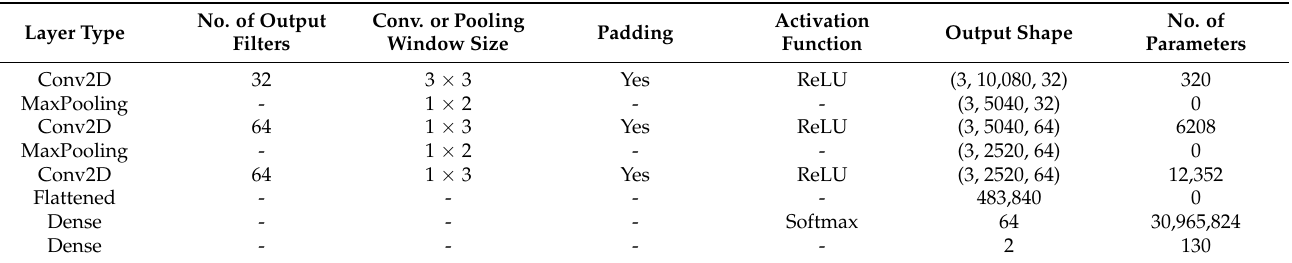
Table 2. Proposed convolutional neural network configuration for week-long three-component geo- magnetic field recordings with a sampling rate of 1 sample per minute, implemented in TensorFlow Keras Python libraries [27]. The input matrix is [3 ×